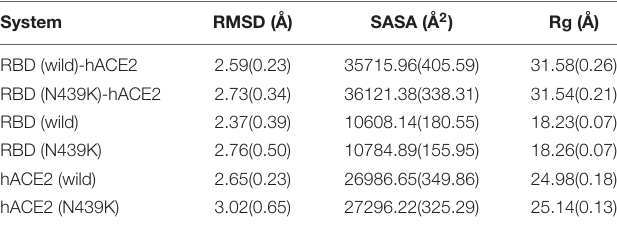
TABLE 1 | The average RMSD, solvent accessible surface area (SASA), and radius of gyration for the simulated